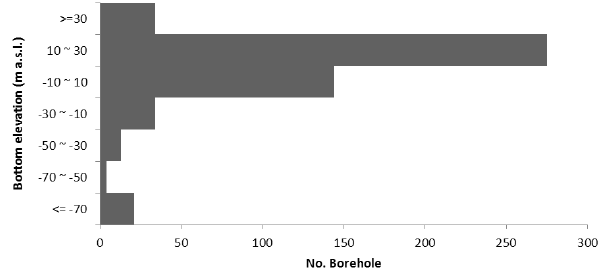
Figure 3. Bottom elevation of boreholes in the model area. In to- tal there are 525 boreholes, but only 22 boreholes are deeper than −